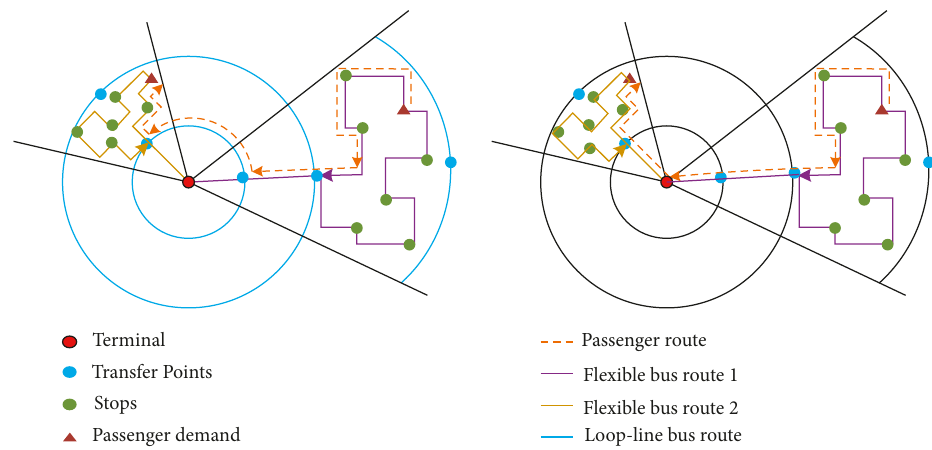
Figure 3: Overall structure of two service